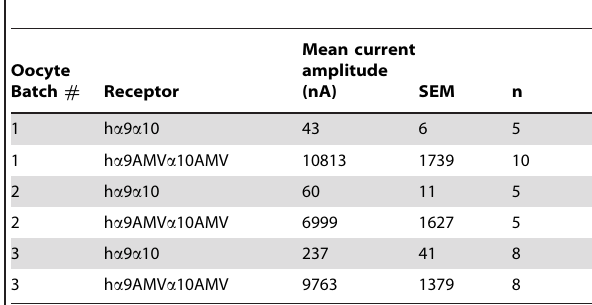
Table 3. Insertion of AMV improves the expression of human a 9 homomeric receptors. a